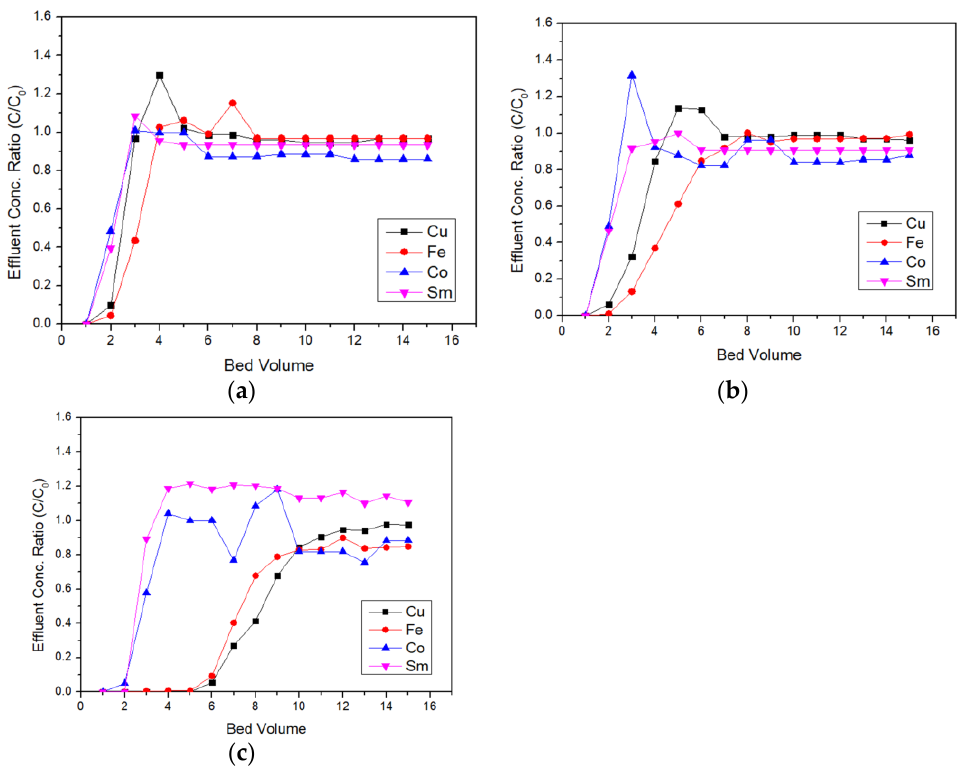
Figure 2. Adsorption curve at ( a ) pH 0.6, ( b ) pH 1, and ( c ) pH 2.